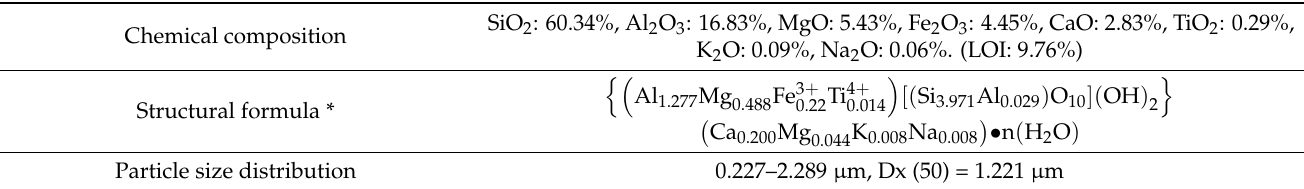
Table 1. The chemical composition, structural formula, and particle size distribution of MMt. Chemical